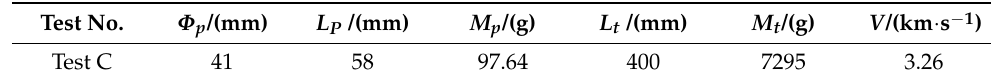
Table 7. Comparison test parameters [36].